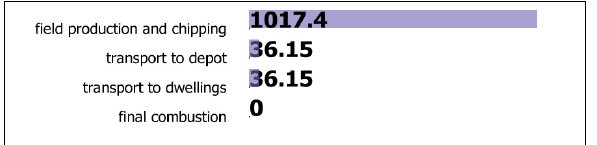
Figure 13. Amount of non-renewable primary energy associated with the nodes practice concerning the use of the local poplar woodchips for housing heating, MJ / person * year (Magentino- Abbiatense context).